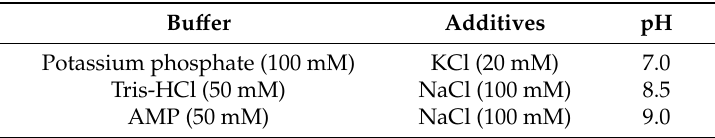
Table 3. Bu ff er compositions used for biophysical